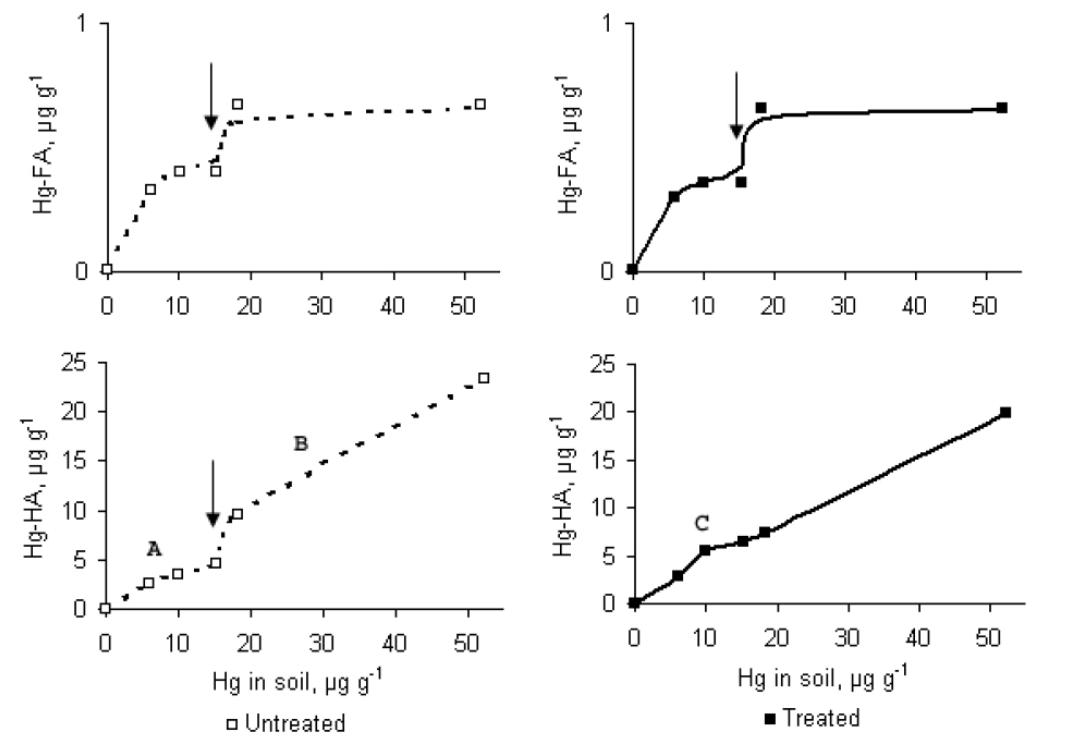
Fig. 4 Hg content in fulvic (Hg-FA) and humic (Hg-HA) acids, untreated and treated